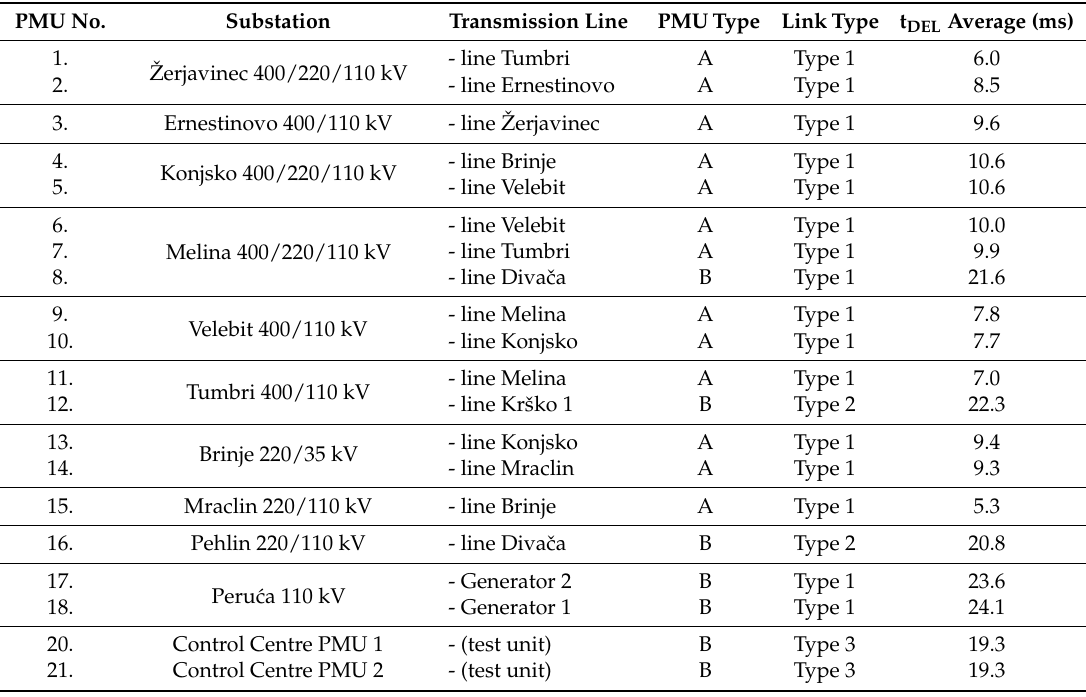
Table 2. Time delays recorded by phasor data concentrators (PDC) application. PMU No.